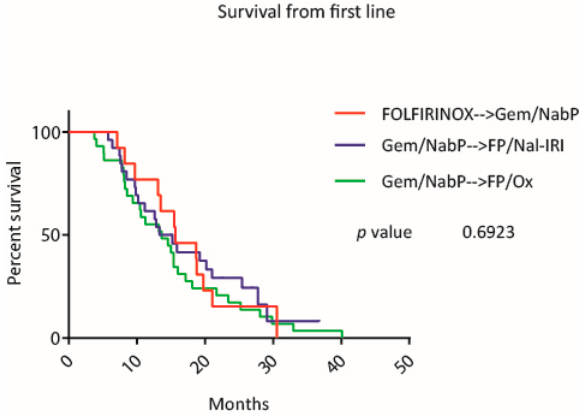
Figure 8. Survival with different first to second line treatment sequences. Kaplan-Meier curves of patients who were treated with one of the three treatment sequences from first to second line: mFOLFIRINOX followed by gemcitabine / nab-paclitaxel (red line), gem / nab-paclitaxel followed by fluoropyrimidines / nanoliposomal irinotecan (blue line) and gemcitabine / nab-paclitaxel followed by fluoropyrimidines / oxaliplatin (green line).